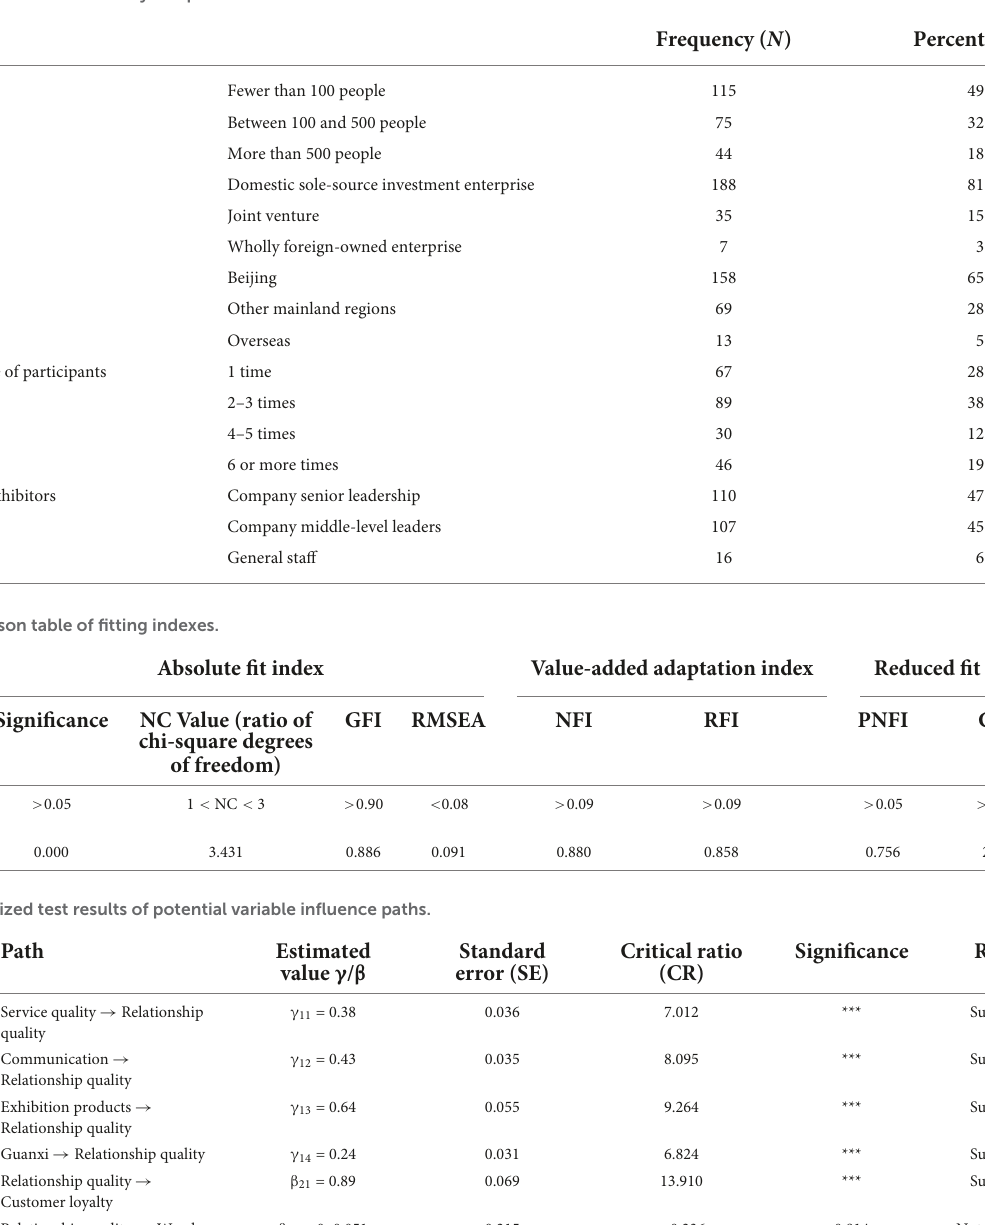
TABLE 5 Basic information of survey samples.